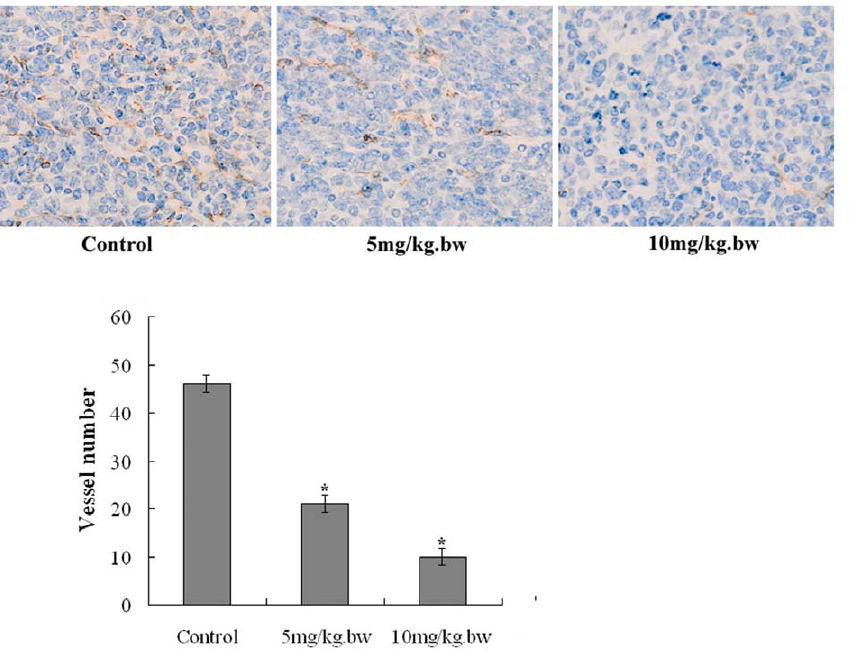
Figure 7. Fcoidan inhibited the tumor angiogenesis in vivo. Representative photographs of the tumor sections examined by immunohistochemical staining for CD34 showing tumor vasculature ( 6 400). The microvessel number was reduced apparently in the tumors belonging to the mice treated with fucoidan. Each bar represents the average vessel number for each group, expressed as mean 6 SD. * P , 0.05 vs Control.